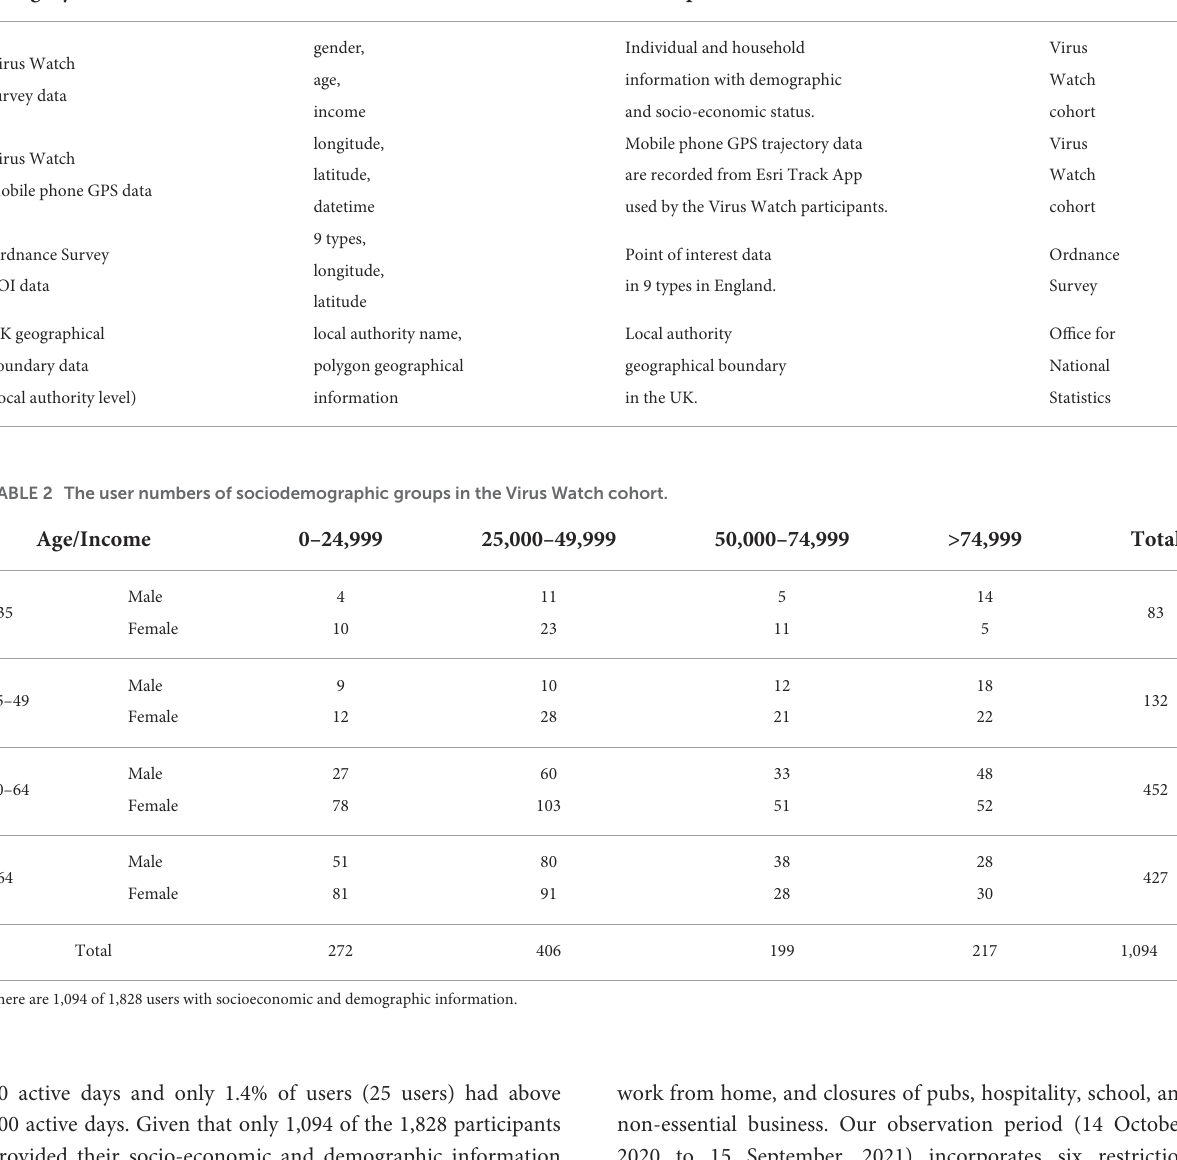
Table 3. The largest observed user numbers are found in “Third National lockdown’ with 965 and the minimal observed user numbers is in ‘Post-restriction” with 153. To clarify, the total observed user frequency of six periods are 3,978 from 1,828 users as some users can repeatedly occur at some restriction periods. Such uneven distribution of observed objects in each